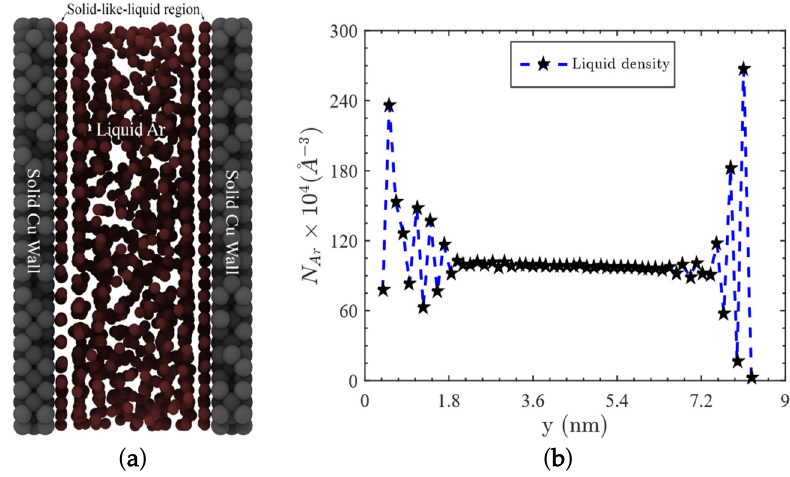
Figure 3. (a) The ’Solid-like-liquid’ region (Rendered from xz plane for gap thickness, h = 2 nm) (b) Number density distribution of the nanoconfined liquid.